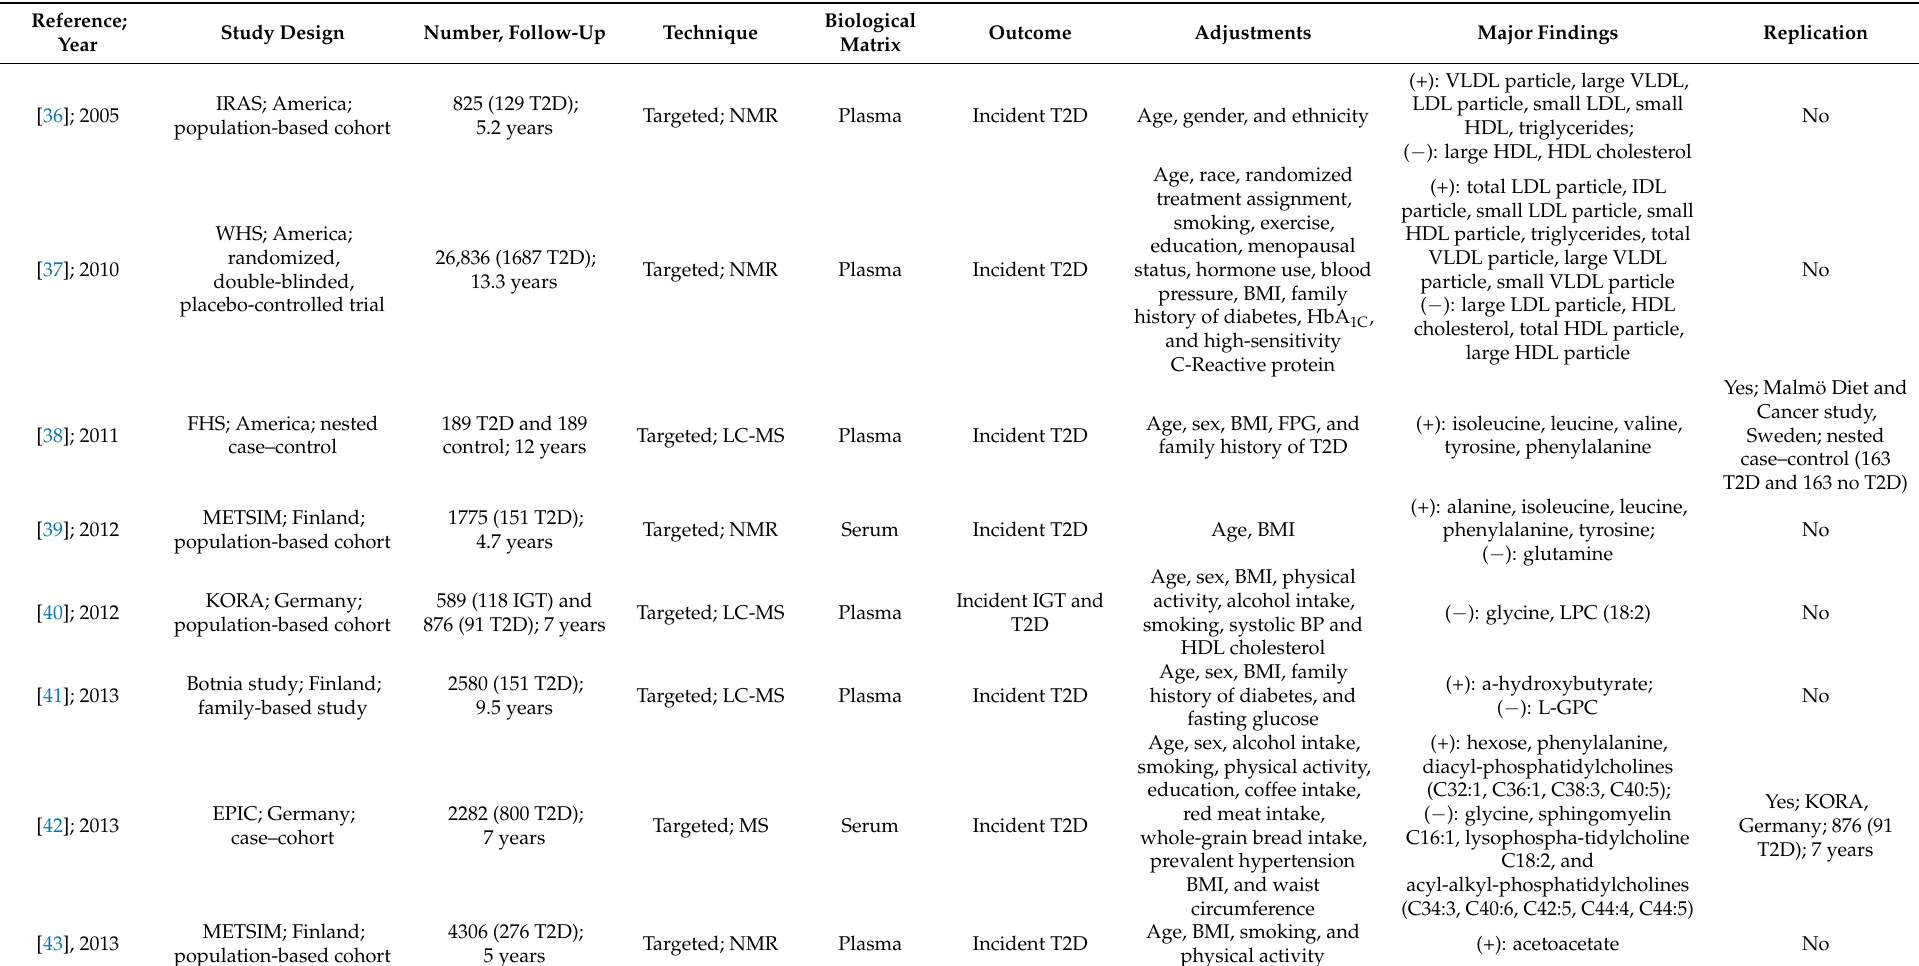
Table 2. Circulating metabolites associated with type 2 diabetes in prospective epidemiological